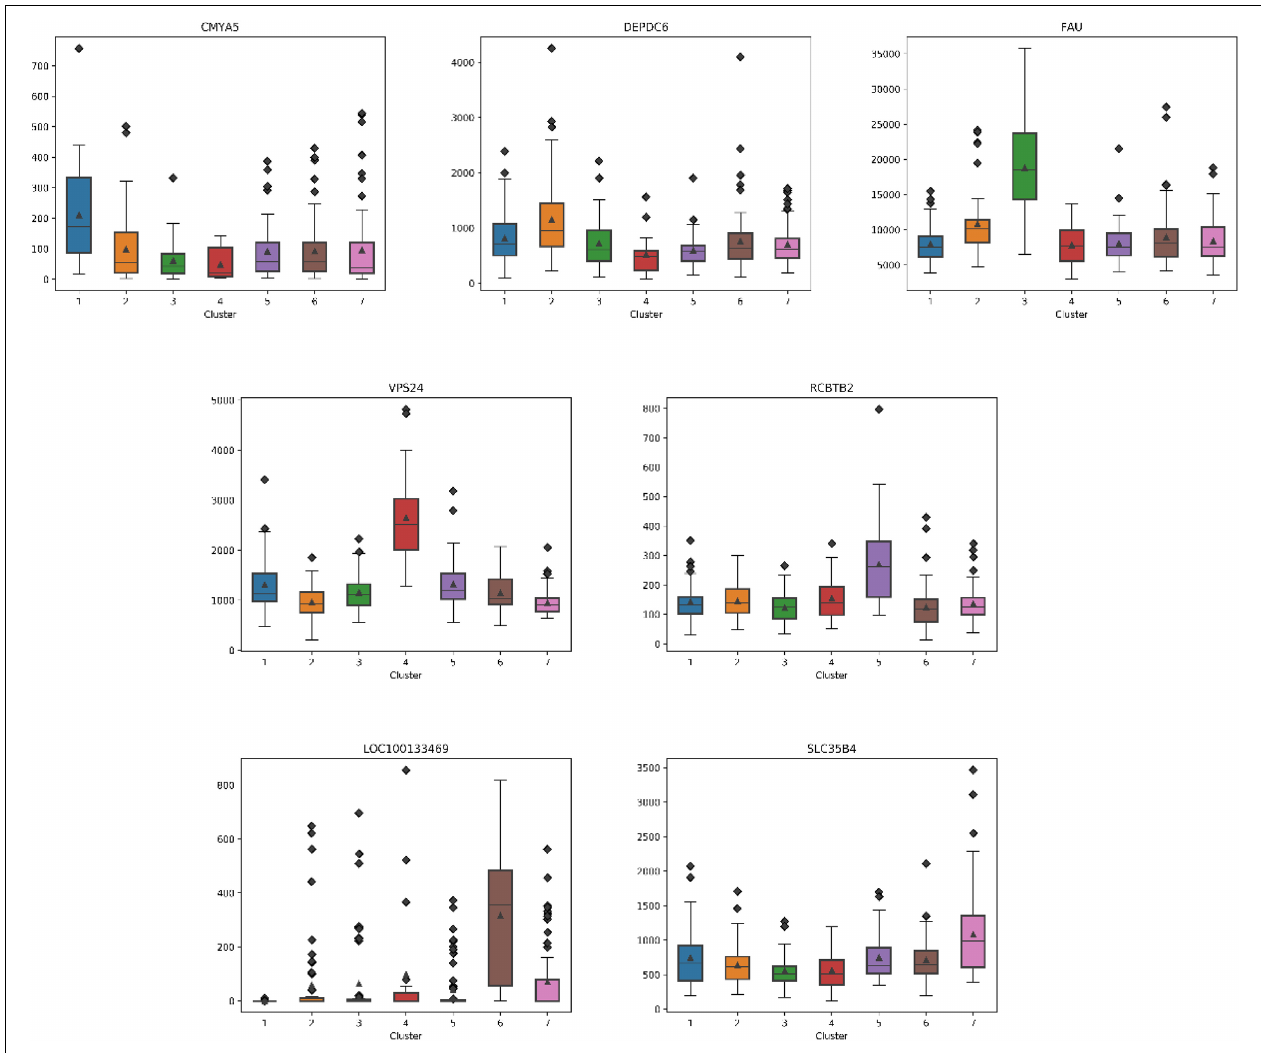
FIGURE 5 | The boxplots for essential genes supporting each subtype on